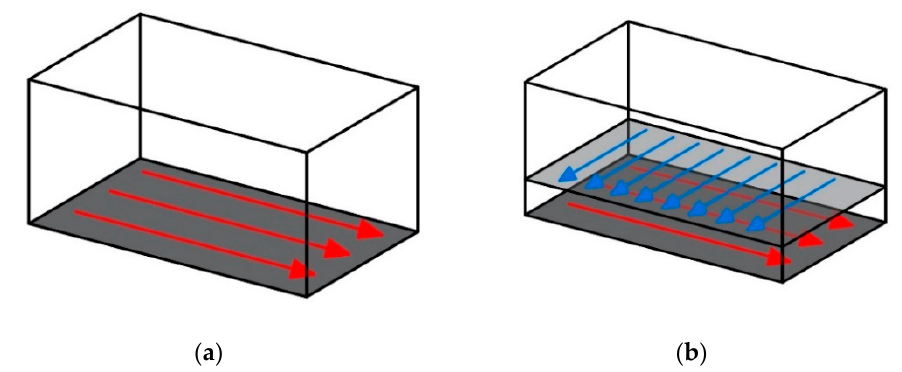
Figure 3. Motion tracks of the laser head during powder melting: ( a ) Sample no. 1, the “parallel” technique; ( b ) sample no. 2, the “perpendicular” technique.